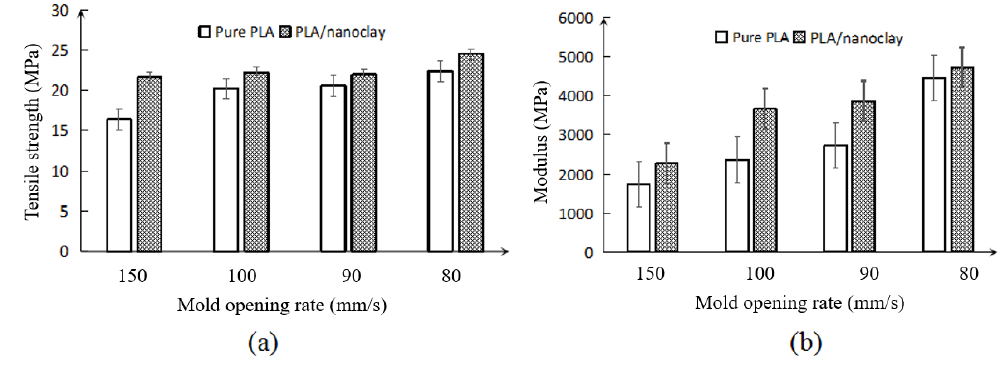
Figure 5. Tensile properties of foamed pure PLA and PLA–nanoclay ( a ) tensile strength; ( b ) tensile modulus.